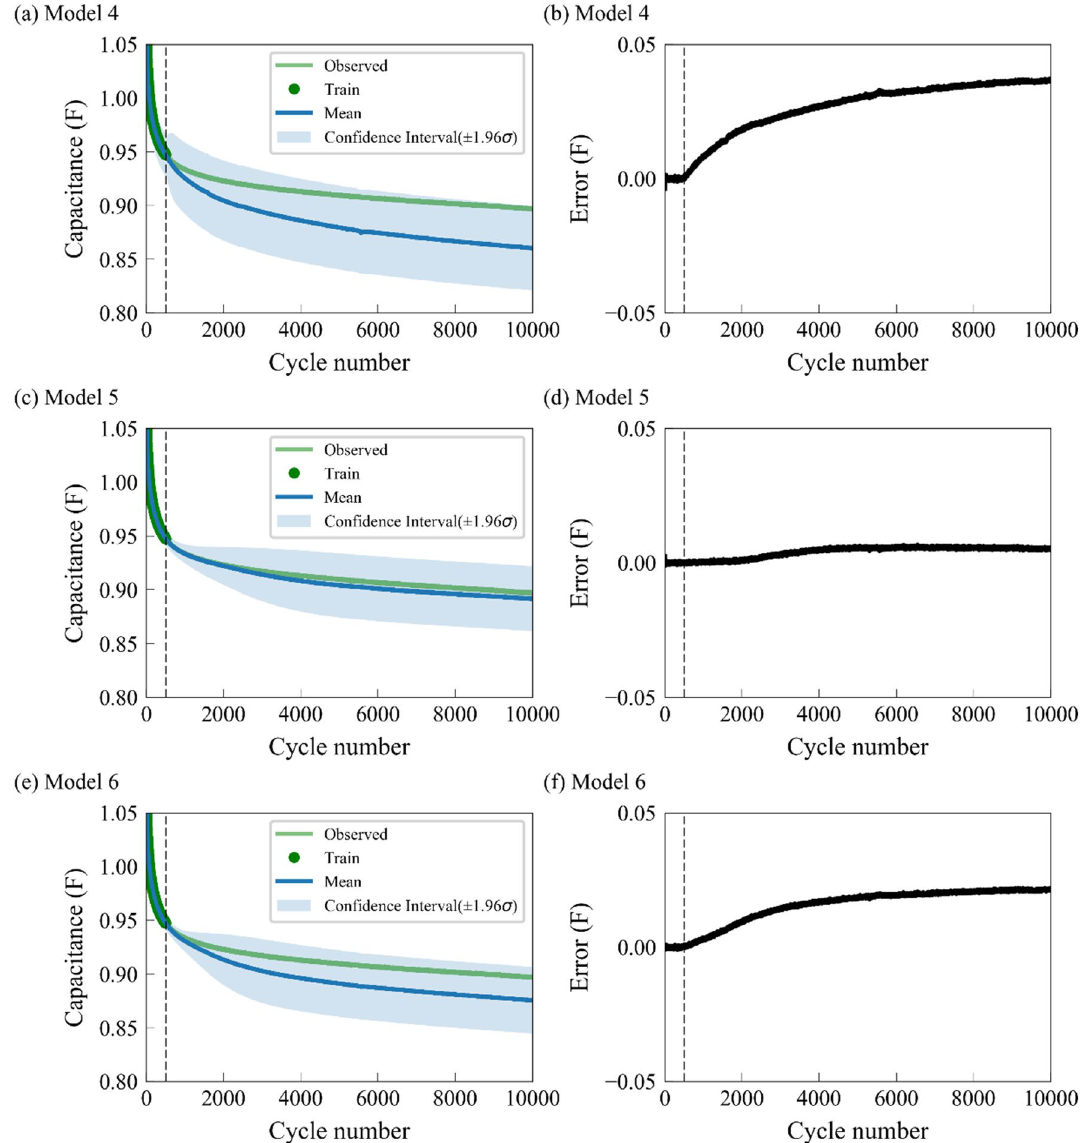
Figure 5. The predictions of the GPR models with different mean functions and compound covariance functions, where the first 5% cycles are used for training. The dotted line indicates the 500th cycle. ( a,c,e ) are the predicted capacitances of an SC for Models 4, 5, and 6, while ( b,d,f ) denote the predicted errors (observed − mean). The green and blue curves represent the observed and predicted mean capacitance, while the green dots and blue shaded areas denote the predicted training data and confidence interval, respectively. The selection of ± 1.96 for confidence interval is based on Eq.